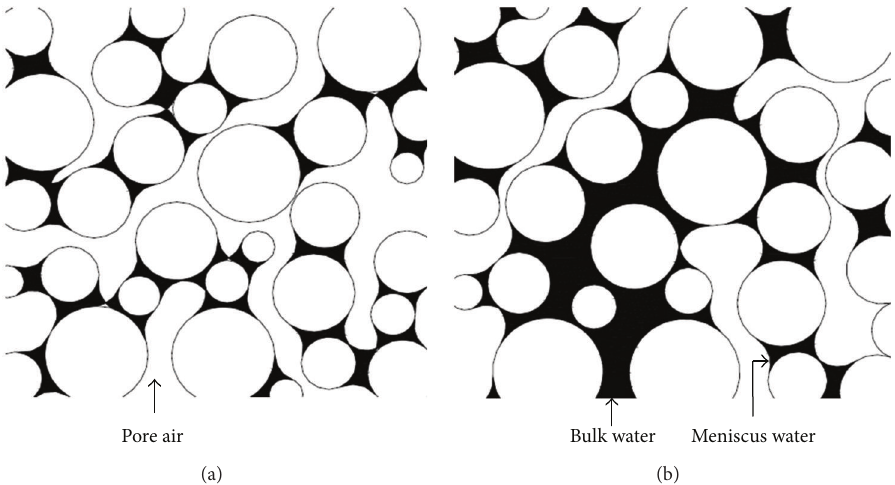
Figure 2: Effect of hydraulic history on the moisture distribution: (a) idealized moisture distribution pattern; (b) after several wetting-drying cycles (after Wheeler et al. (2003)